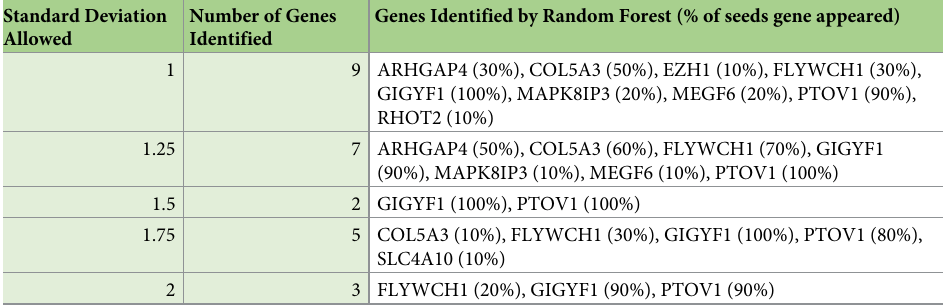
Table 2. Random forest results with increasing standard deviation multiplicative factor separating AIH patients and healthy